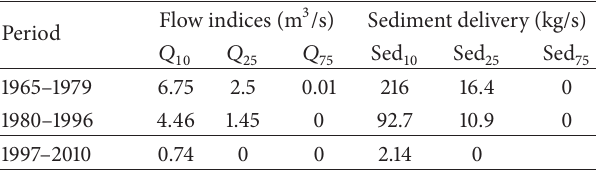
Table 2: FDC analysis for different periods at Huangfu